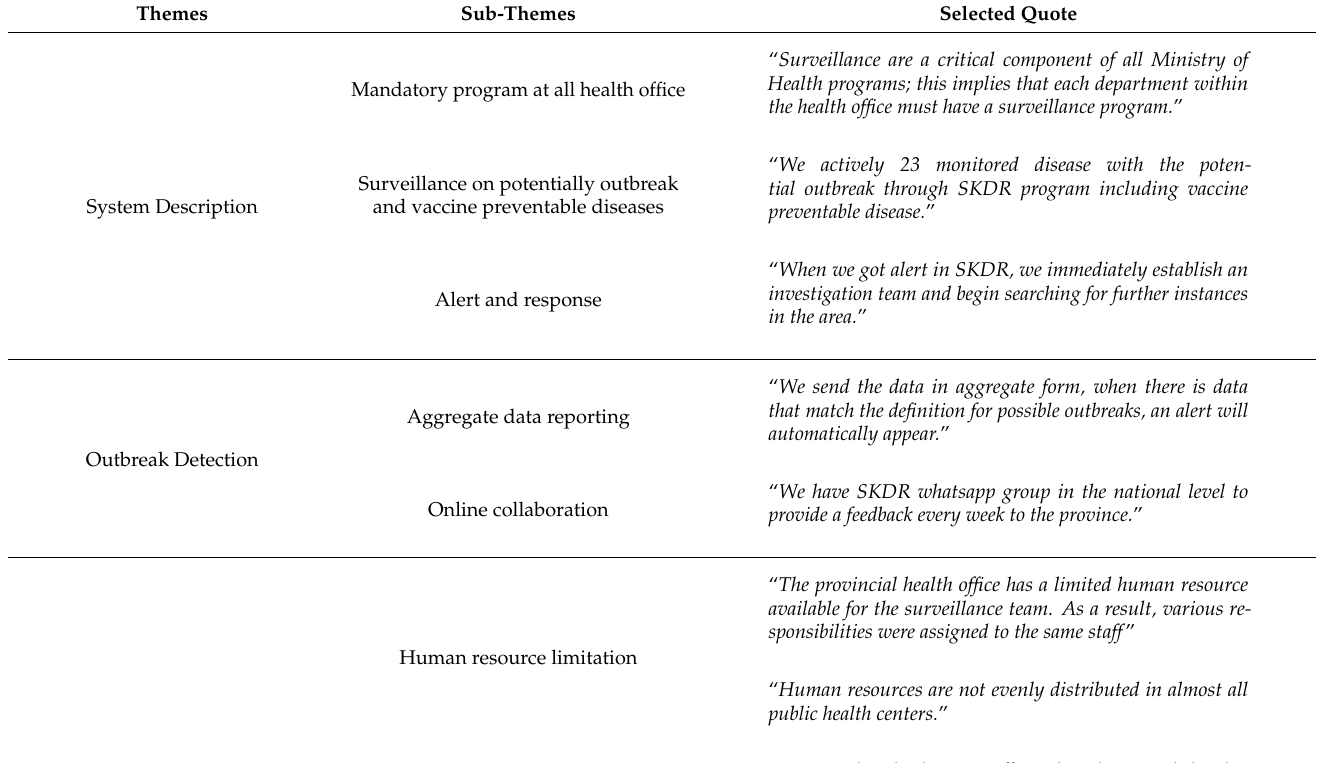
Table 3. Summary of qualitative analysis on EWARS system in